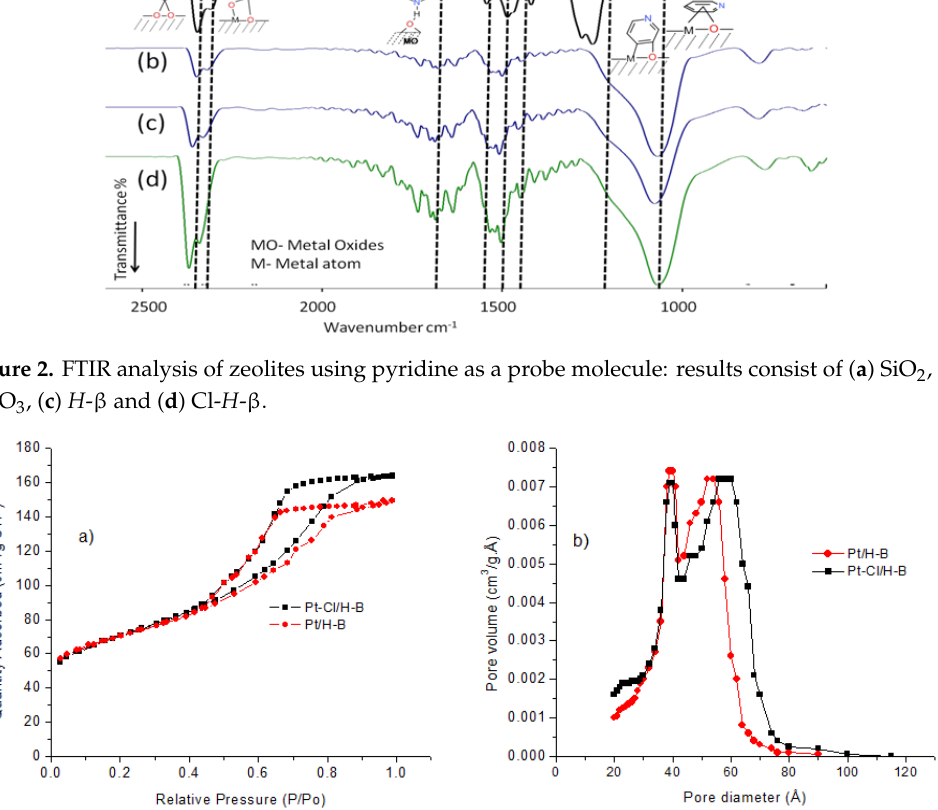
Table 4. Physicochemical properties of the hydro-isomerisation product from 10 H-ULSD by Pt-Cl / H - β -zeolitein GHSV = 1180 mln / (g.cat).h. ** Not available; IBP—Initial Boling Point; FBP—Final Boiling Point; # polyaromatic hydrocarbon (PAH) (tri + ) should be less than 0.02% with diesel grade.